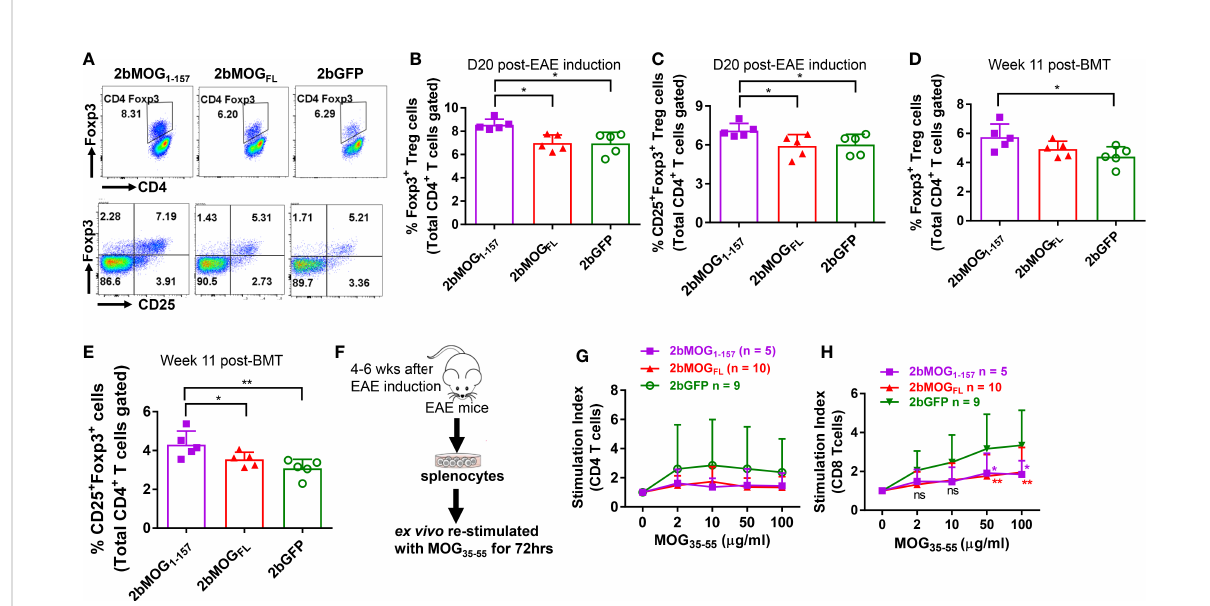
FIGURE 6 Platelet-targeted MOG 1-157 expression lead to Treg accumulations and suppressed CD8 T cell recall responses to MOG 35-55 stimulation. Leukocytes from peripheral blood at 11 weeks after transplantation of transduced HSCs before EAE induction and 20 days after EAE induction were stained for CD4, CD25, and Foxp3 and analyzed by fl ow cytometry. One to two months after EAE induction, splenocytes from transduced recipients were isolated, labeled with Violet CellTracer, and cultured with various doses (0, 2, 10, 50, and 100 m g/ml) of MOG 35-55 peptide for 3 days. Cells were harvested and stained for CD4 and CD8. Zombie Red ™ staining was used to exclude dead cells. After staining, cells were analyzed by fl ow cytometry. (A) Representative dot plots of fl ow cytometry analysis of Treg cells in transduced recipients after EAE induction are shown. (B) The percentages of Foxp3 + Treg cells in transduced recipients after EAE induction are shown. (C) The percentages of CD25 + Foxp3 + Treg cells in transduced recipients after EAE induction are shown. (D) The percentages of Foxp3 + Treg cells in transduced recipients before EAE induction are shown. (E) The percentages of CD25 + Foxp3 + Treg cells in transduced recipients before EAE induction are shown. (F) The work fl ow of the T cell proliferation assay is shown. (G) The stimulation index of CD4 T cell proliferation in each group cultured with various concentrations of MOG 35-55 is shown. (H) The stimulation index of CD8 T cell proliferation in indicated groups with various concentrations of MOG 35-55 is shown. The stimulation index (SI) was calculated asfollows: SI= (the percentage ofproliferating daughtercells in MOG 35-55 -treated wells)/ (the percentageof proliferating daughter cells incontrol wells with 0 m g/ml of MOG 35-55 ).Two-way ANOVAwas used tocompareT cell stimulation indexes amonggroups. *P< 0.05; **P < 0.01. (B – E,G, H) Each datapoint represents one mouse. Data weresummarized fromtwo